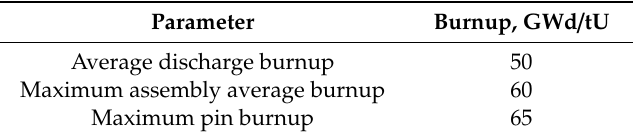
Table 5. Summarised data about burnups for BWR fuel as used in this study [38].